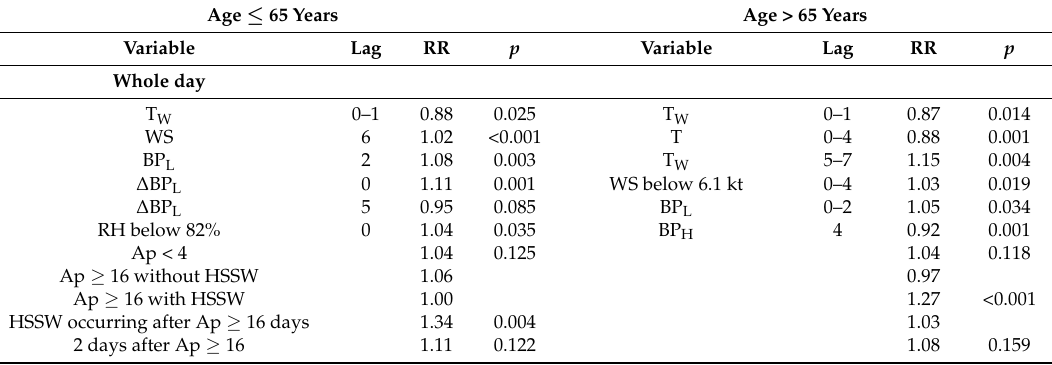
Table 5. Associations between environmental variables and emergency calls for EABP for patients aged >65 years and for younger patients, in rate ratios of space weather categories and per increase of standard unit * in weather variables; adjusting for day length, month, years, and the day of the